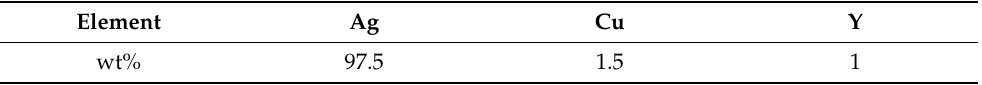
Table 1. Chemistry composition (weight percentage, wt%) of the Ag–1.5Cu–1.0Y alloys.